Question: Looking at the figure, what chart type is it?
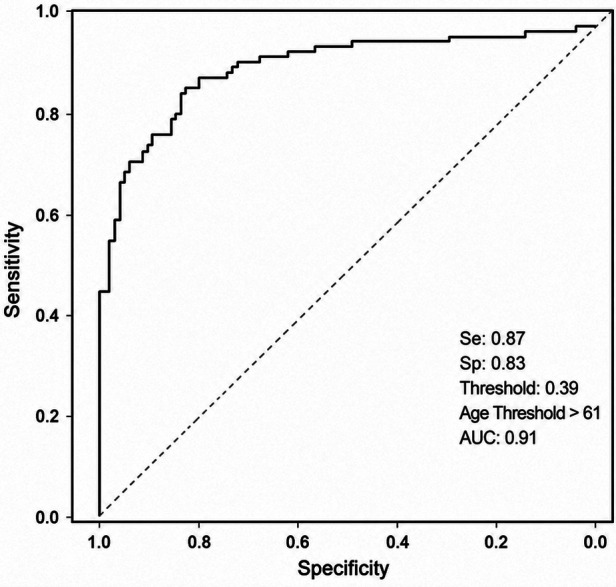
Answer: line